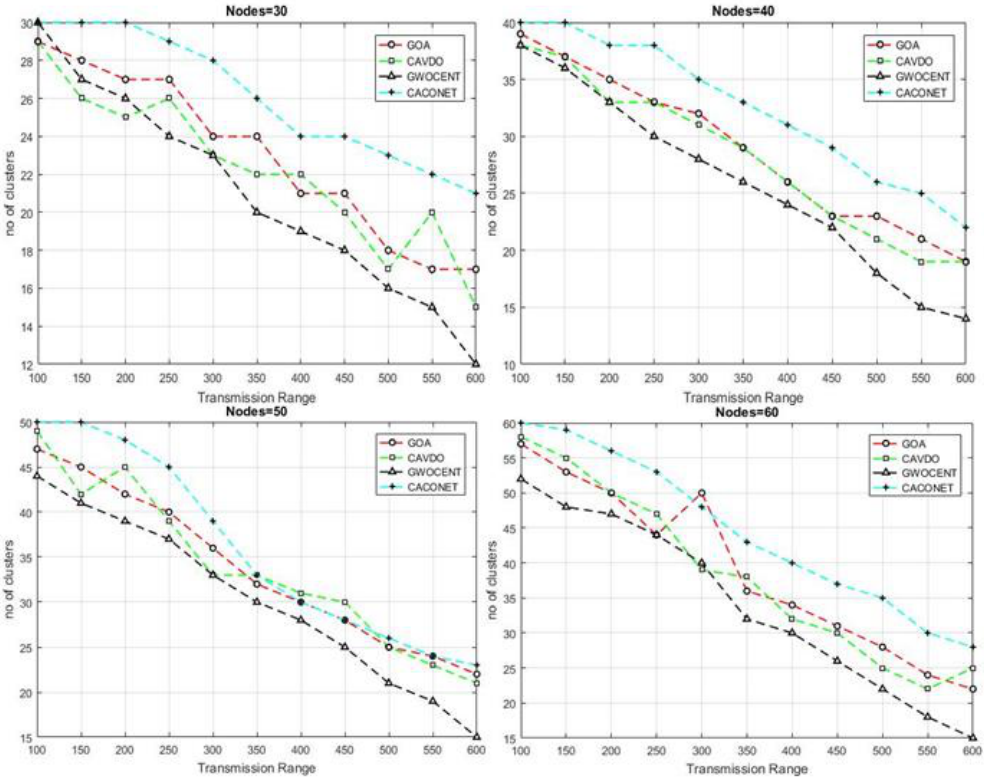
Figure 8. The number of clusters vs. Tx Range for 4 Km 2 × 4 Km 2 .